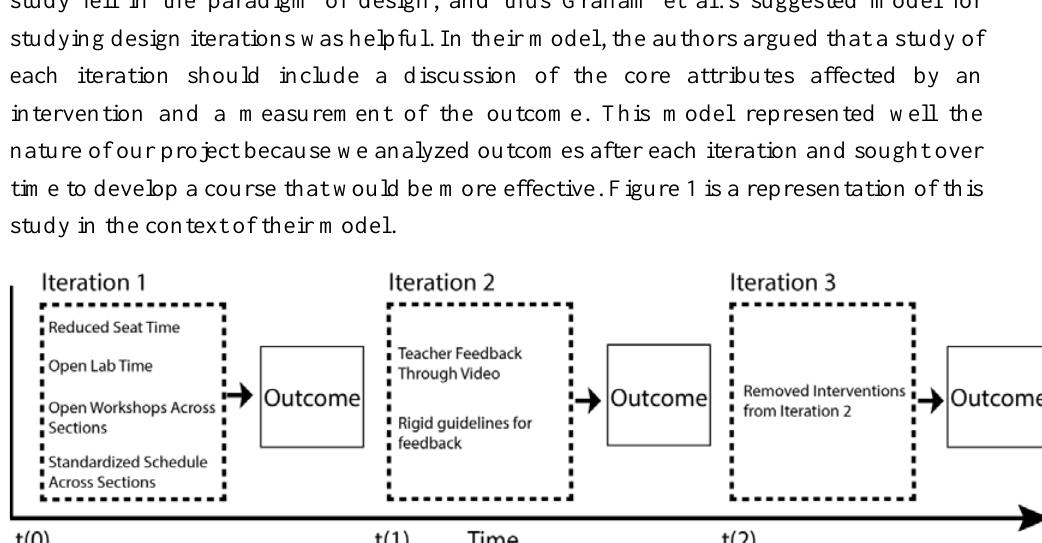
In following this model, we engaged in the following design iterations. These interventions are more fully explained in a subsequent